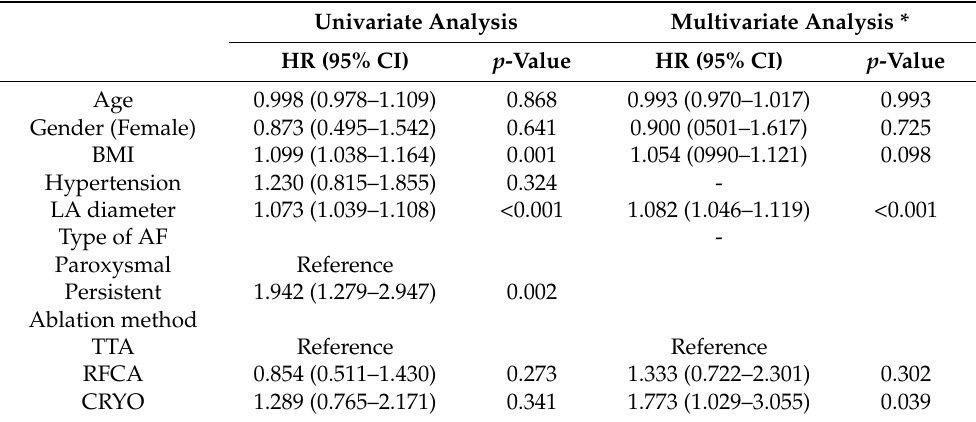
Table 4. Cox regression for predictors of